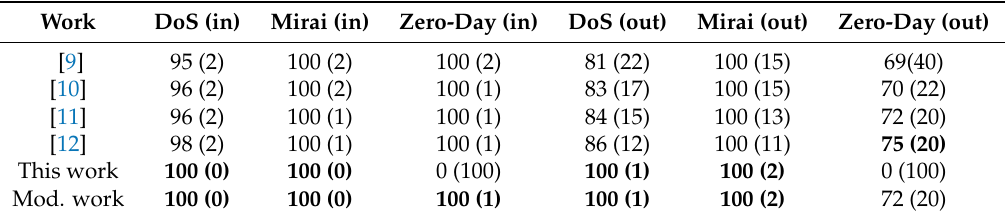
Figure 17. Intrusion Detection Mode after Detected 2. Table 1. Comparison of works on intrusion detection by autonomous embedded systems. Numbers correspond to the percentage of true positive intrusion detection and, in parentheses, the corresponding percentage of false positive